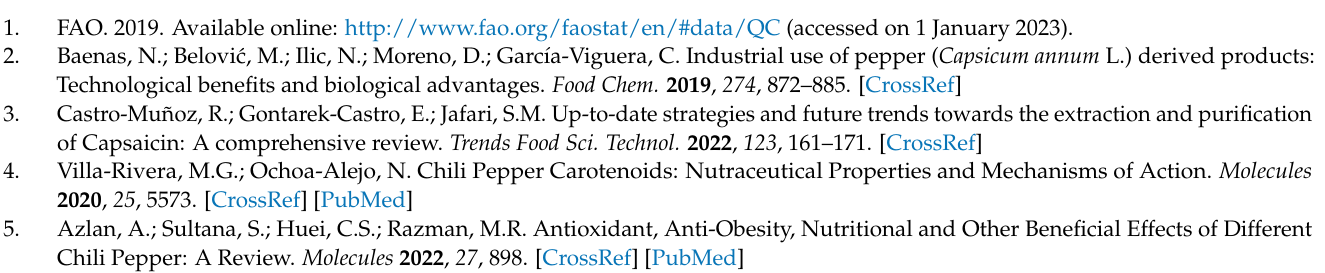
Figure S4: Chromatograms of capsanthin, zeaxanthin, lutein, β -cryptoxanthin and β -carotene